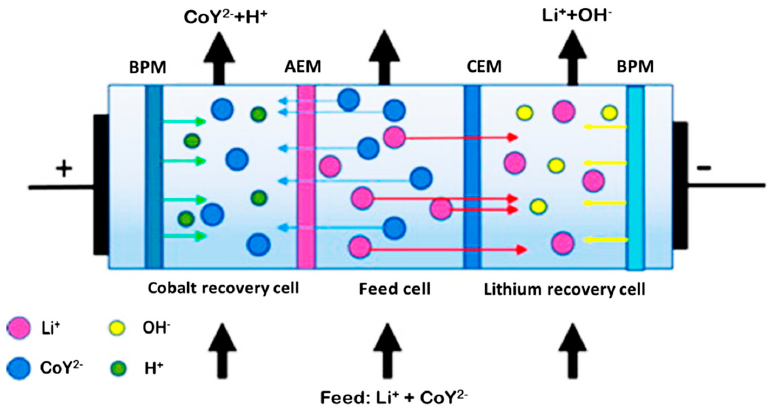
Figure 16. Principle of method for separation of cobalt and lithium based on electrodialysis